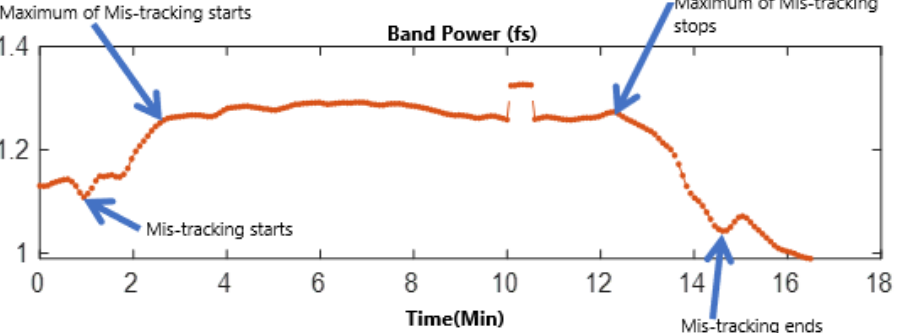
Figure 6. Power feature values over time for the signals collected during tracking experiments and 20 kg load condition.